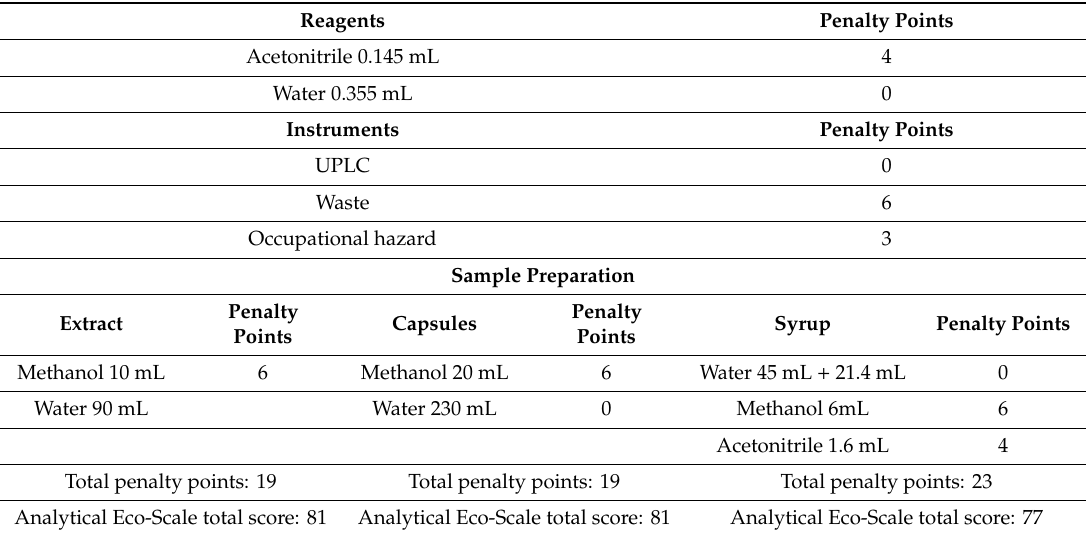
Table 6. Evaluation of penalty point for UPLC method in the analysis of one sample.